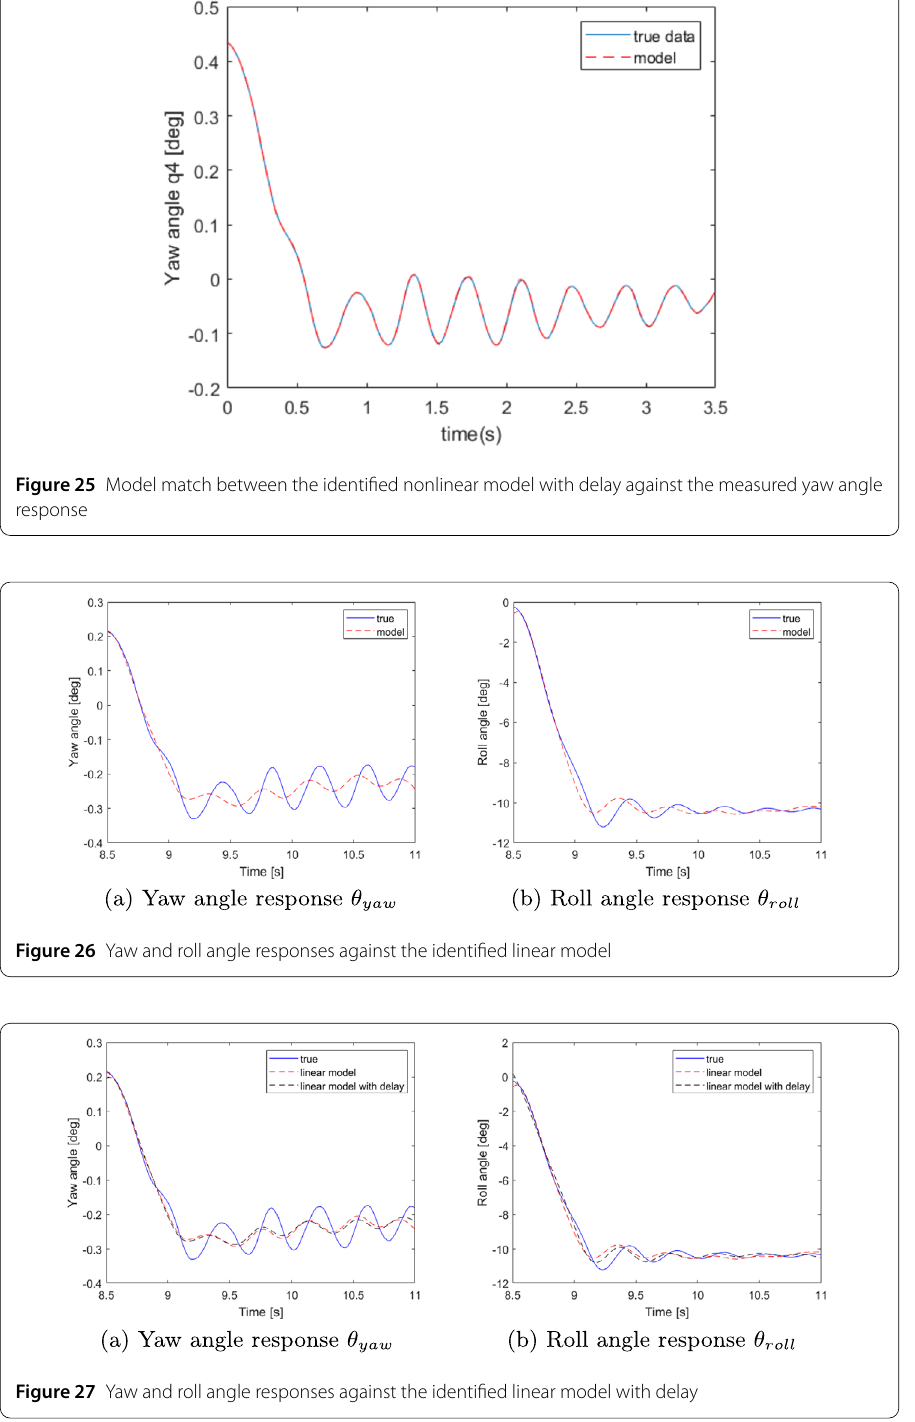
are again tested against the 25–35 degrees step change data, as was done with the non- delay case. The 40–60 degrees step change data is used as validation data for the models LMD yaw,40 , LMD roll,40 , LMD yaw,60 , LMD roll,60, LMD yaw,80 and LMD roll,80 , as well as their nonlinear versions. The 60–80 degrees step change data is used as validation data for